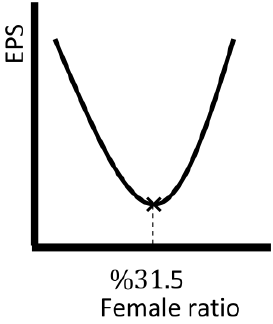
Figure 5. The critical female ratio in non-financial firms with respect to EPS.